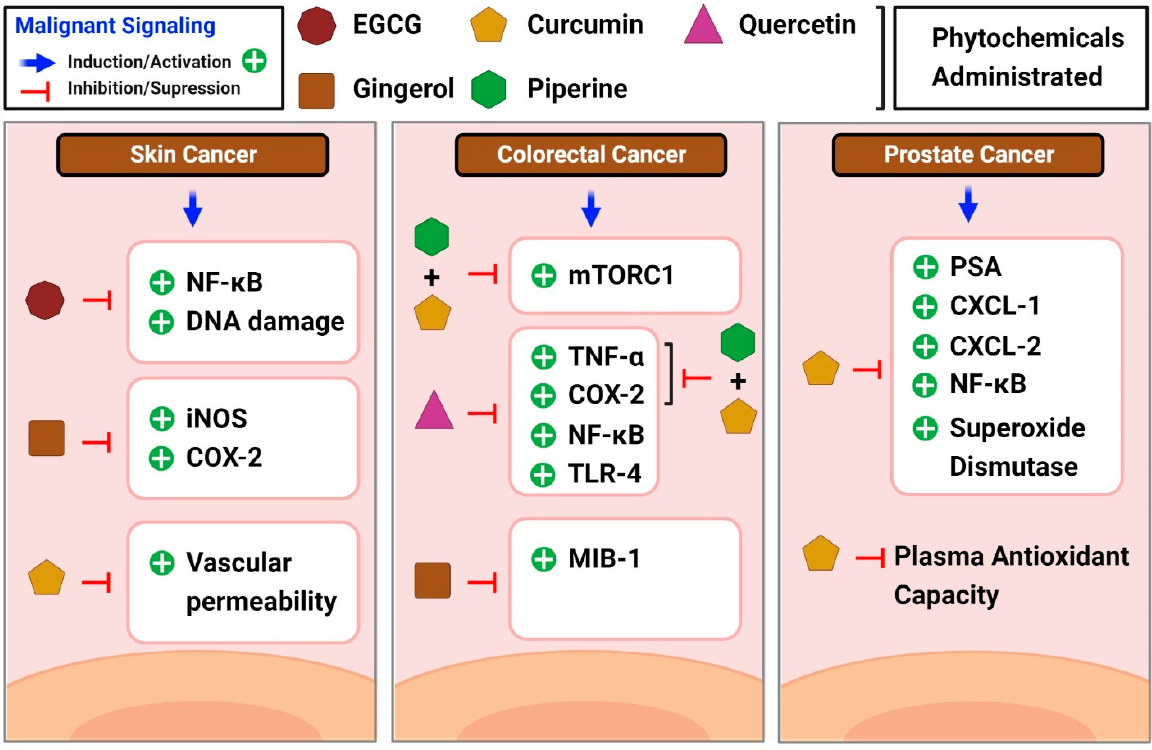
Figure 6. A brief overview of the common inflammatory markers linked to different cancer types and moderating effects shown by phytochemicals in the diseases.